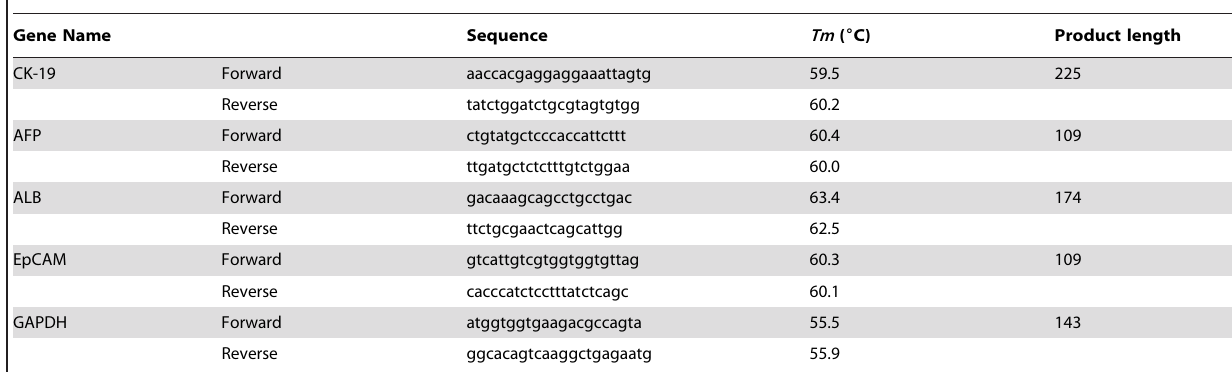
Table 1. The primers used in the QRT-